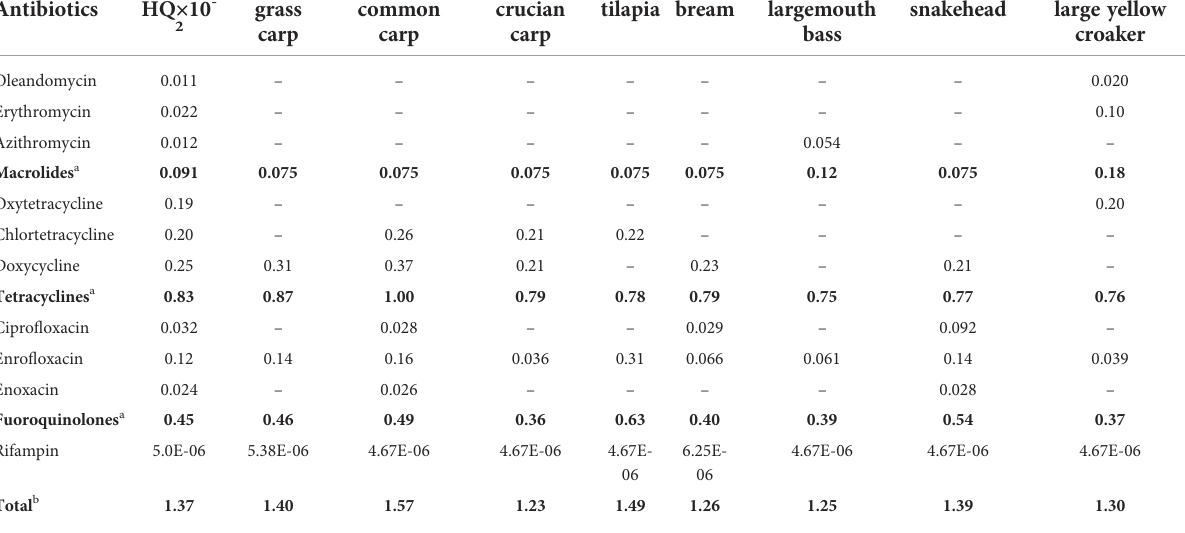
TABLE 4 HQ of 28 antibiotics based on the estimated daily exposure dose per aquatic